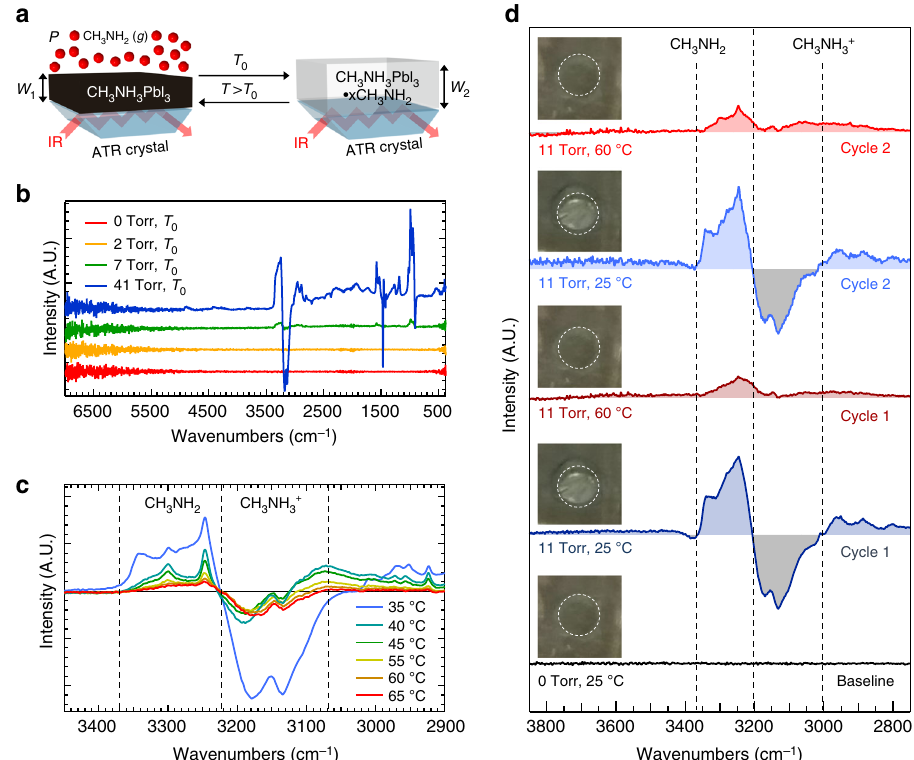
Fig. 3 In situ differential FTIR of complex formation and dissociation. a Diagram illustrating reversible pressure and temperature modulation of complex formation and dissociation on an ATR crystal. Intercalation and complex formation results in an increase in fi lm thickness ( W 2 > W 1 ). b Differential FTIR spectra at increasing CH 3 NH 2 pressure. Spectra are offset for clarity. c Stretching vibrations due to methylamine (CH 3 NH 2 ) and methylammonium (CH 3 NH 3 + ) species for temperatures 35 – 65 °C at a constant 41 Torr CH 3 NH 2 pressure. d Spectra showing two bleached-to-colored cycles of the CH 3 NH 3 PbI 3 • x CH 3 NH 2 fi lm at 20 Torr CH 3 NH 2 . Dashed vertical lines serve to guide the eye. Spectra are offset for clarity. The background due to thin fi lm interference of each spectrum was subtracted with a polynomial fi t (Supplementary Fig. 3). Inset images show that the bleached state was observed at 25 ° C, and the colored state is achieved at 60 °C. Dashed white circles highlight the ATR crystal. The stage around the ATR crystal is not